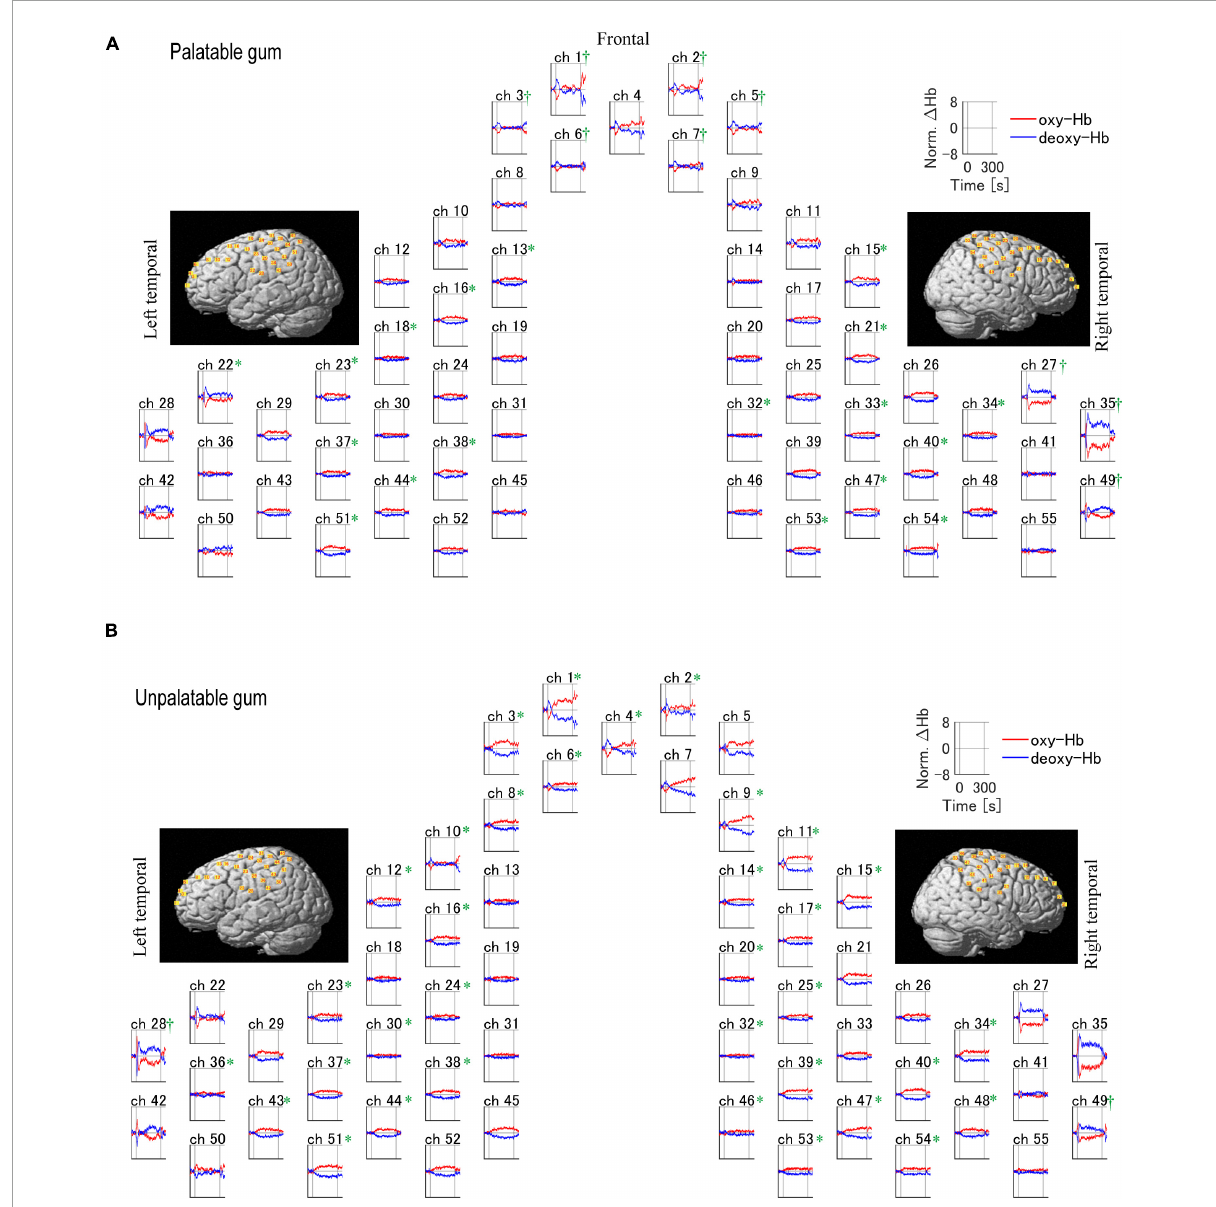
FIGURE5 Temporal profiles of changes of the hemodynamic response during the chewing of palatable/unpalatable gums. The average waveform for all participants is shown. (A) Palatable gum; (B) unpalatable gum. ∗ A significant increase in the area under the curve (AUC) was observed after chewing relative to baseline ( p < 0.05). † A significant decrease in AUC was observed after chewing relative to baseline ( p < 0.05). The one-sample Kolmogorov–Smirnov